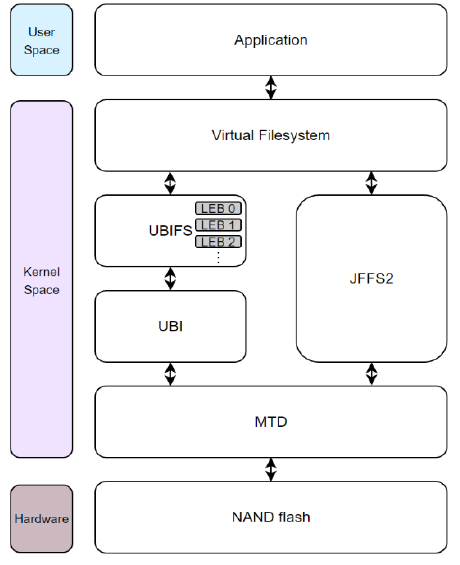
Figure 2. JFFS2 and UBIFS architecture on Linux.